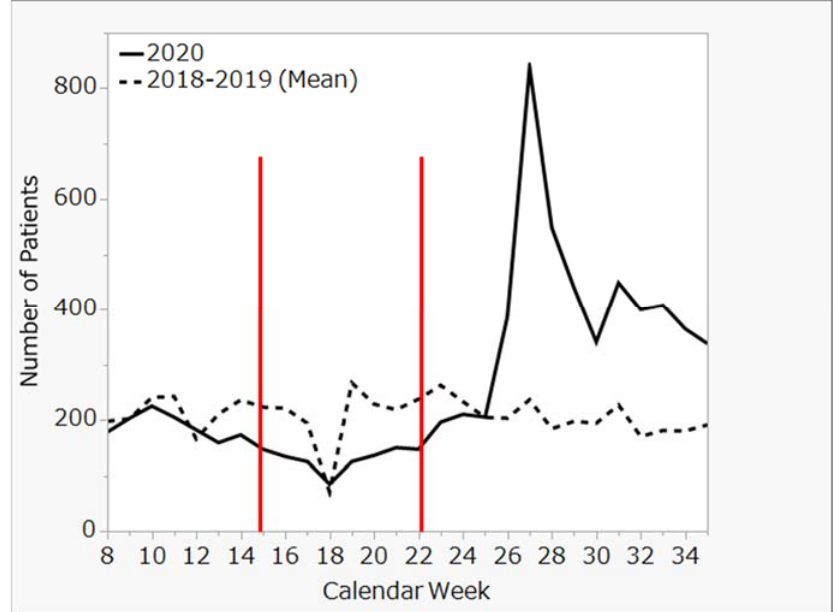
Figure 1. Trends in number of diabetes patients from Tokyo from 2018 through 2020.